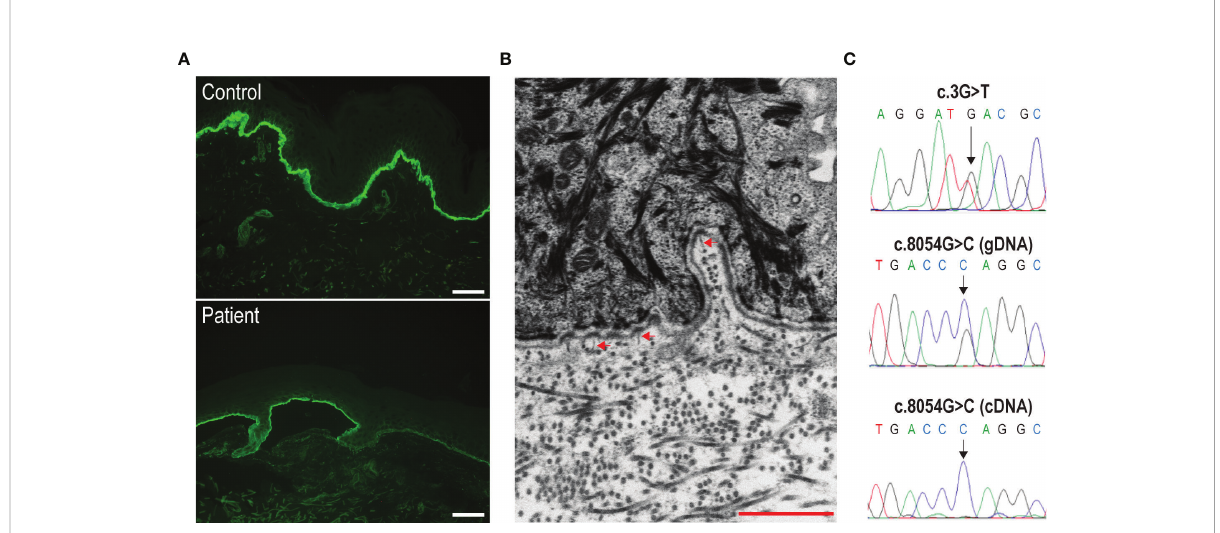
FIGURE 2 Immuno fl uorescence antigen mapping, and ultrastructural and molecular genetic fi ndings. (A) Labeling intensity for type VII collagen is reduced in the patient ’ s skin (bottom panel) as compared to control skin (top panel). Bar = 40 µm. (B) Ultrastructural examination shows a few, hypoplastic anchoring fi brils (arrowheads) inserting onto the lamina densa of the cutaneous basement membrane zone in patient ’ s skin. Bar = 1 µm. (C) Detection of the c.3G>T (top panel) and c.8054G>C (middle panel) compound heterozygous mutations by Sanger sequencing of the patient ’ s genomic DNA (gDNA). The sequence of the complementary DNA (cDNA) across the c.8054G/C nucleotide position is also shown (bottom panel). Note that only transcripts carrying the c.8054C variation are